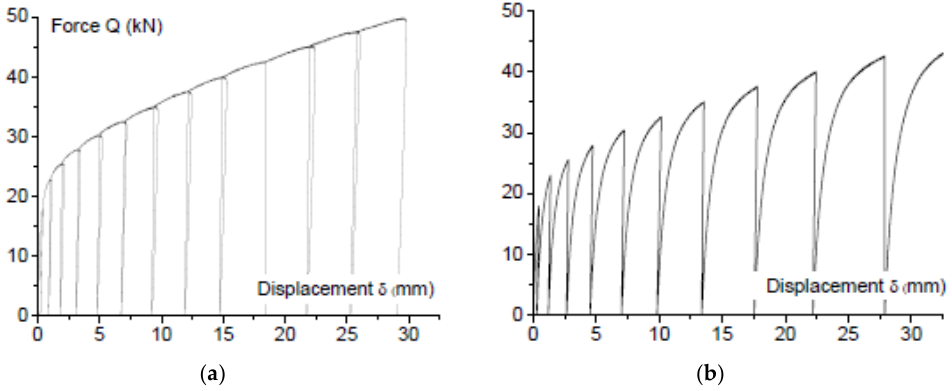
Figure 13. Decomposition of the cyclic curve of specimen DC5 into: ( a ) Skeleton, and ( b ) Bauschinger part; both in the positive load domain.